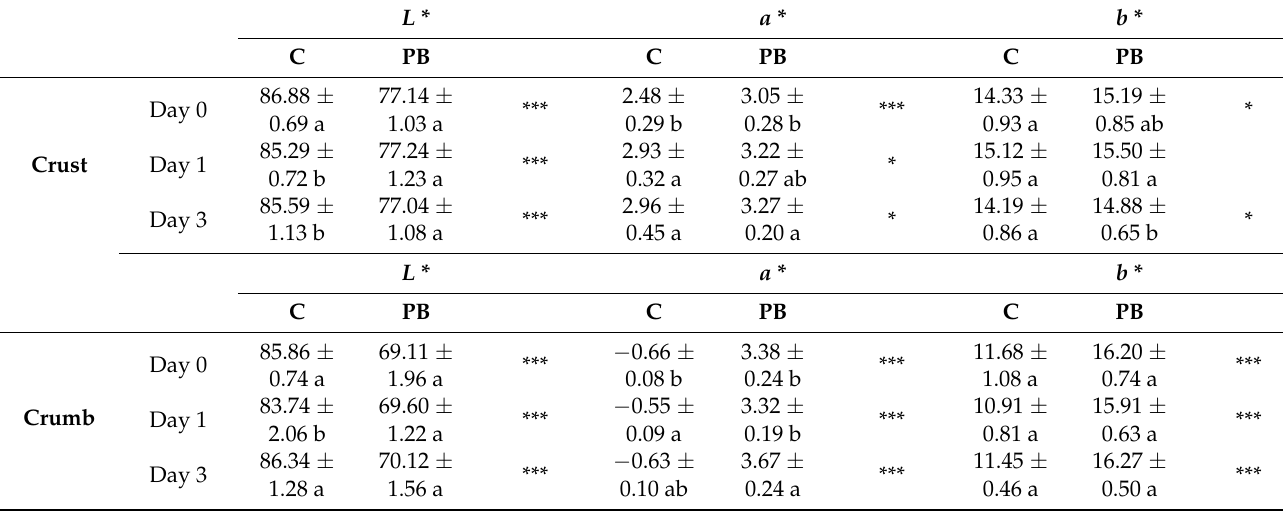
a Means and standard deviations in column followed by different letters significantly differ ( p < 0.05) among different storage times for the same bread. * p < 0.05; ** p < 0.01; *** p < 0.001.